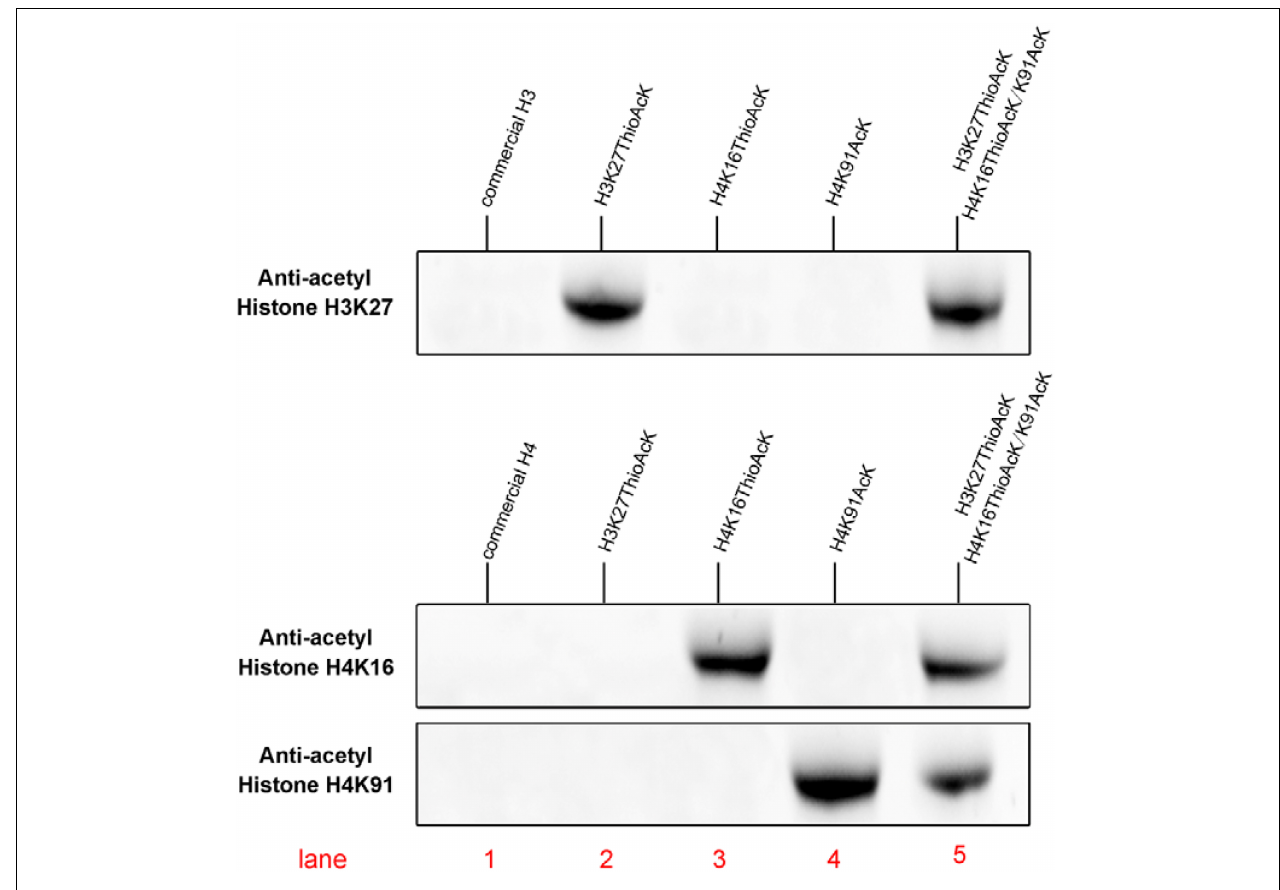
FIGURE 2 | Western Blots of single or multiple ncAAs residues into H3K27_ThioAcK variant on H3 with anti-acetyl histone H3K27AcK antibody, or variants (H4K16_ThioAcK, H4K91_AcK or H4K16_ThioAcK/H4K91_AcK) on H4 with anti-acetyl histone H4K16AcK and H4K91AcK antibodies. 10 µ L of the corresponding PURE reaction solution was loaded into each lane. Lane 1: commercial histone H3 or H4 (10 µ g) as antibody control.